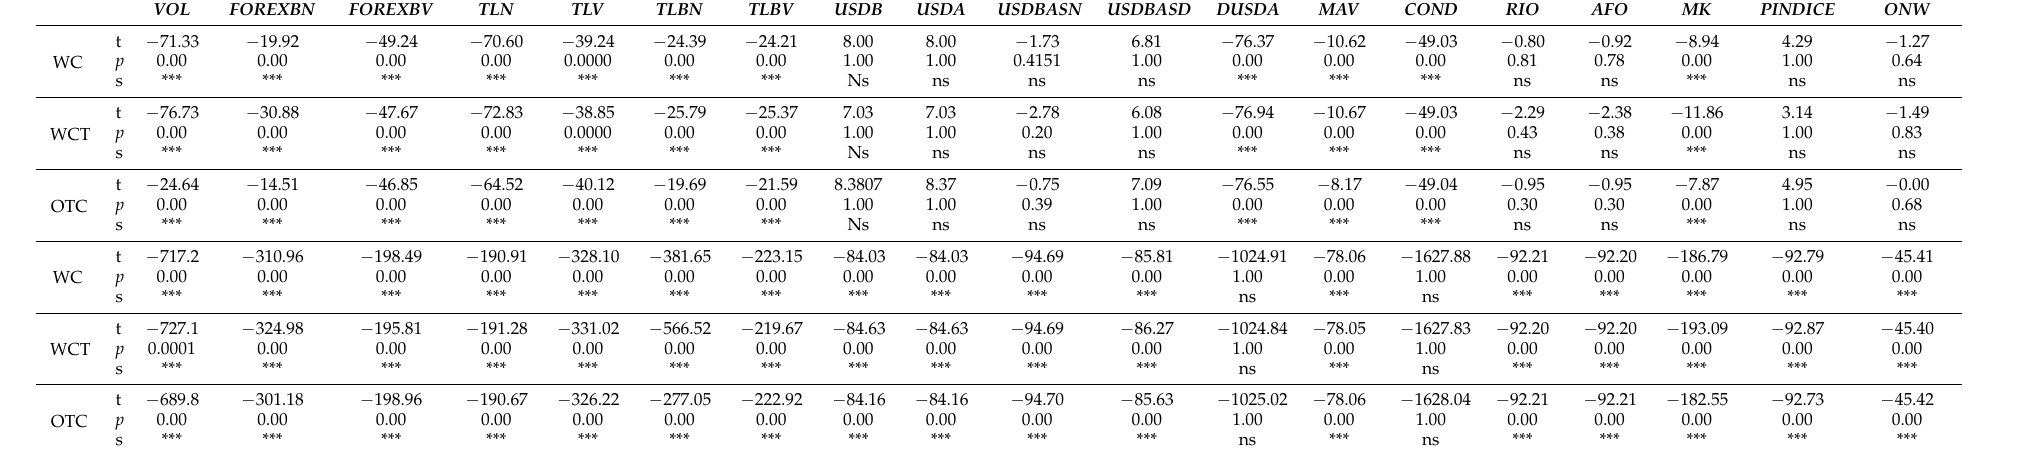
Table 2. Phillips–Perron (PP) unit root test